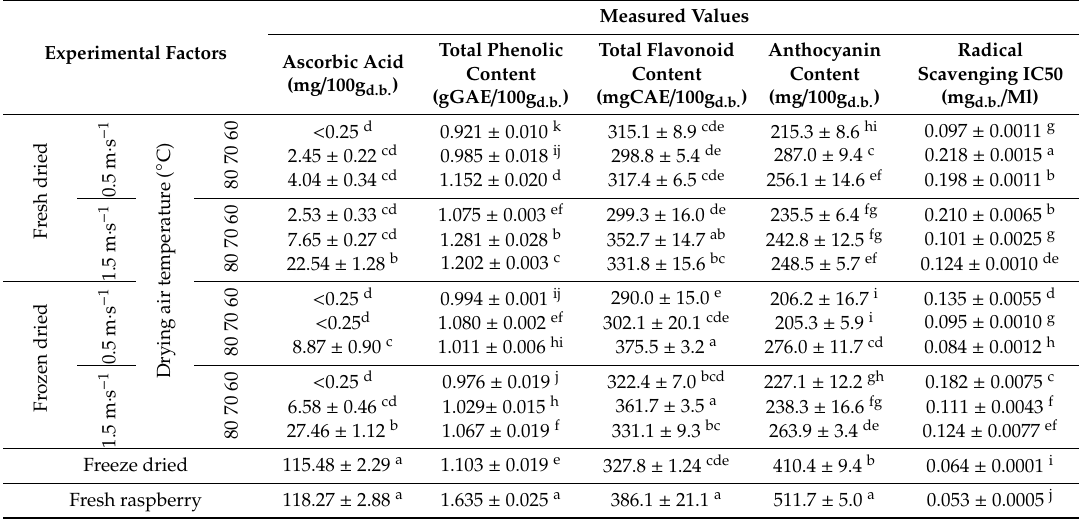
115.48 ± 2.29 a 118.27 ± 2.88